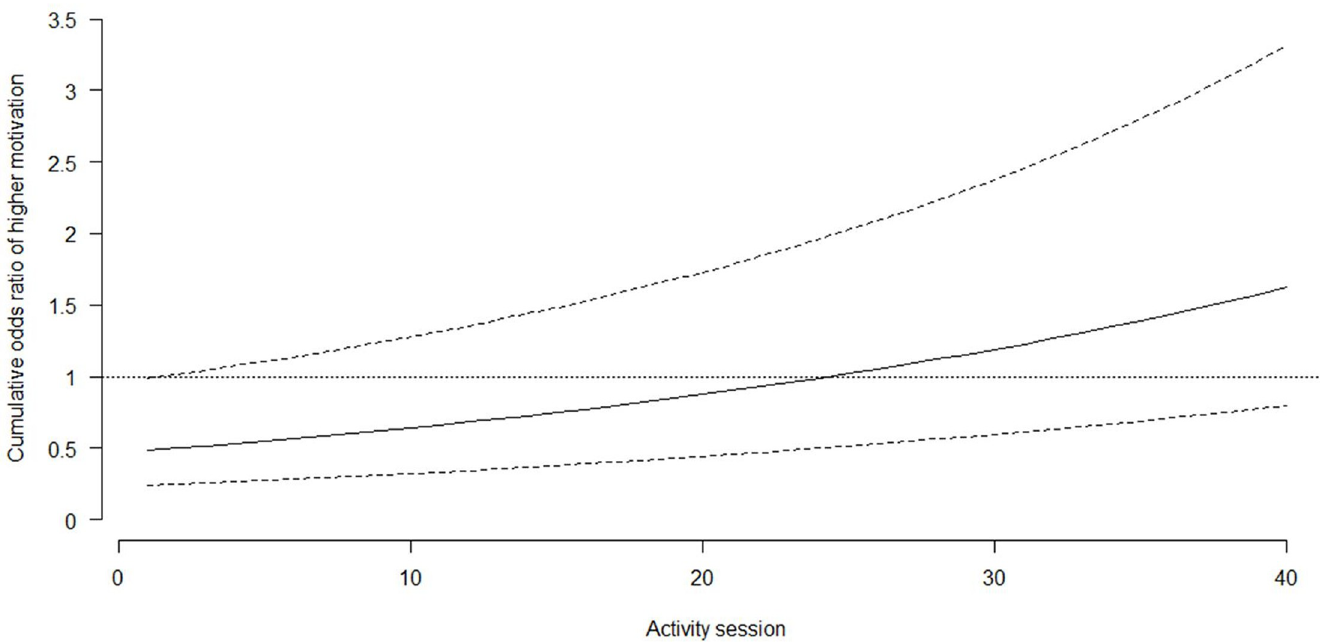
Fig 3. Comparing motivation during activity session in exercise group (solid line) relative to the social activity group (horizontal line 1.0). Dotted lines indicates the 95% confidence interval.